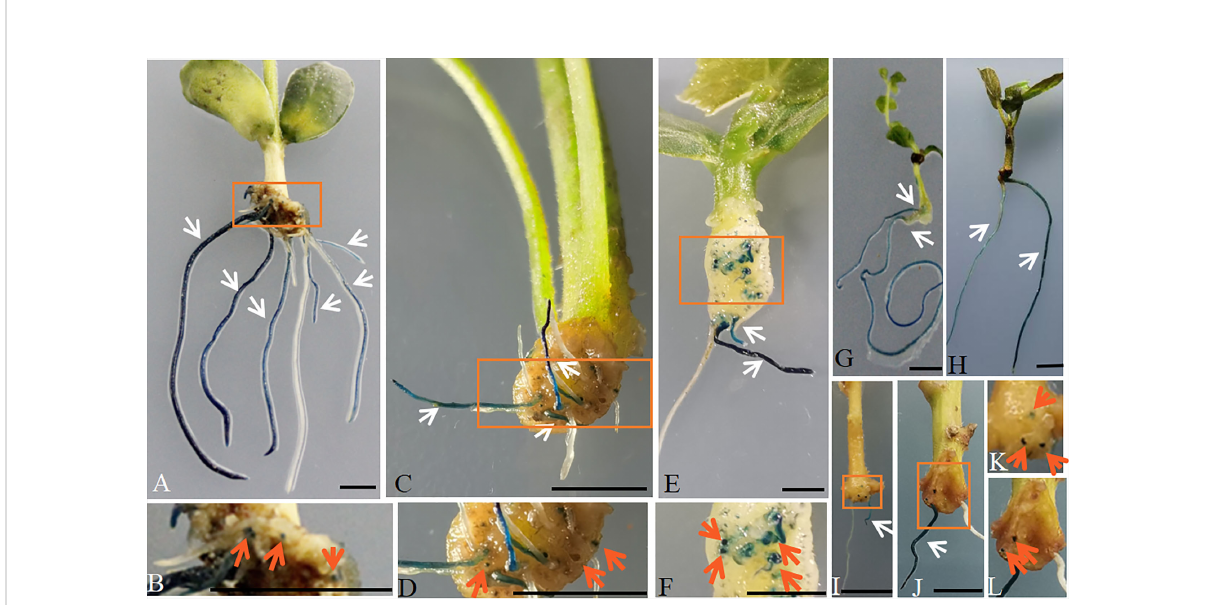
FIGURE 2 Histochemical localization of GUS activity in the p AtGCSpro 2411 :: GUSPlus hairy roots in broad dicots species by ARM transformation. High level of GUS activity was accumulated in the whole transformed p AtGCSpro 2411 :: GUSPlus roots in soybean (A, B) , tomato (C, D) , cucumber (E, F) , L. japonicas (G) , cotton (H) , tobacco (I, K) , sweet potato (J, L) , respectively. White arrows indicate the transgenic roots. Pictures B, D, F, K, L are closed up of sections A, C, E, I, J marked in the orange boxes, respectively. The GUS signal was found in the teratoma where hairy roots can emerge (indicated by orange arrows). All composite plants were observed from 16 to 21 d post-infected seedlings with K599 carrying pRedGa1 construct. Bars = 5